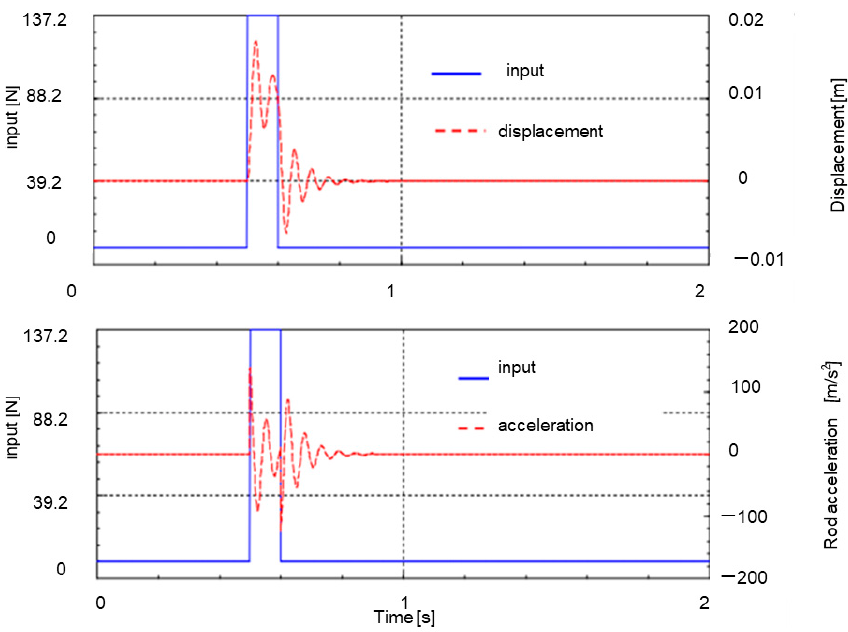
Figure 9. Time vs. rod displacement and acceleration by using spring & air compressibility (example 1).